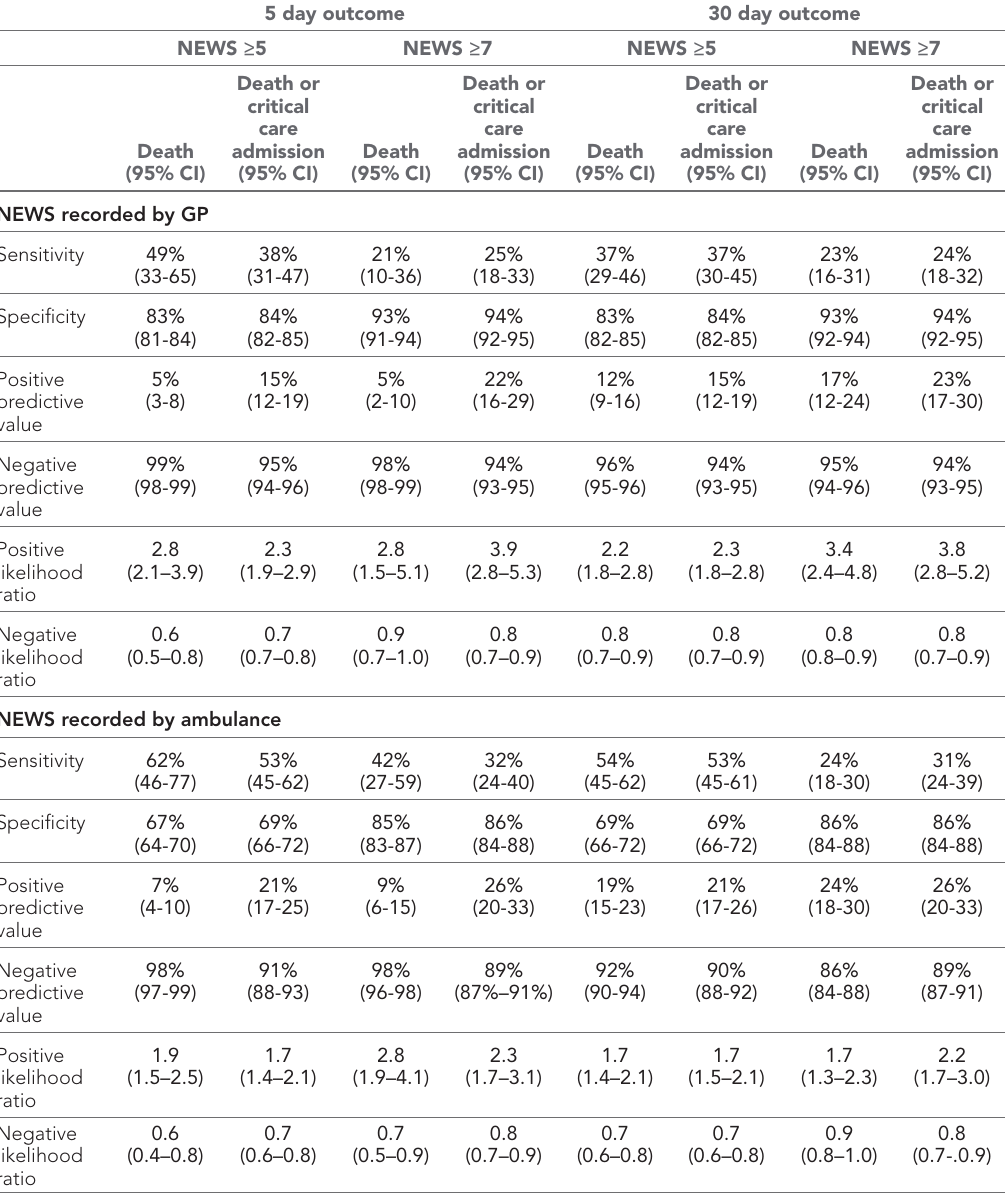
Table 2 Summary of diagnostic performance of NEWS to predict adverse